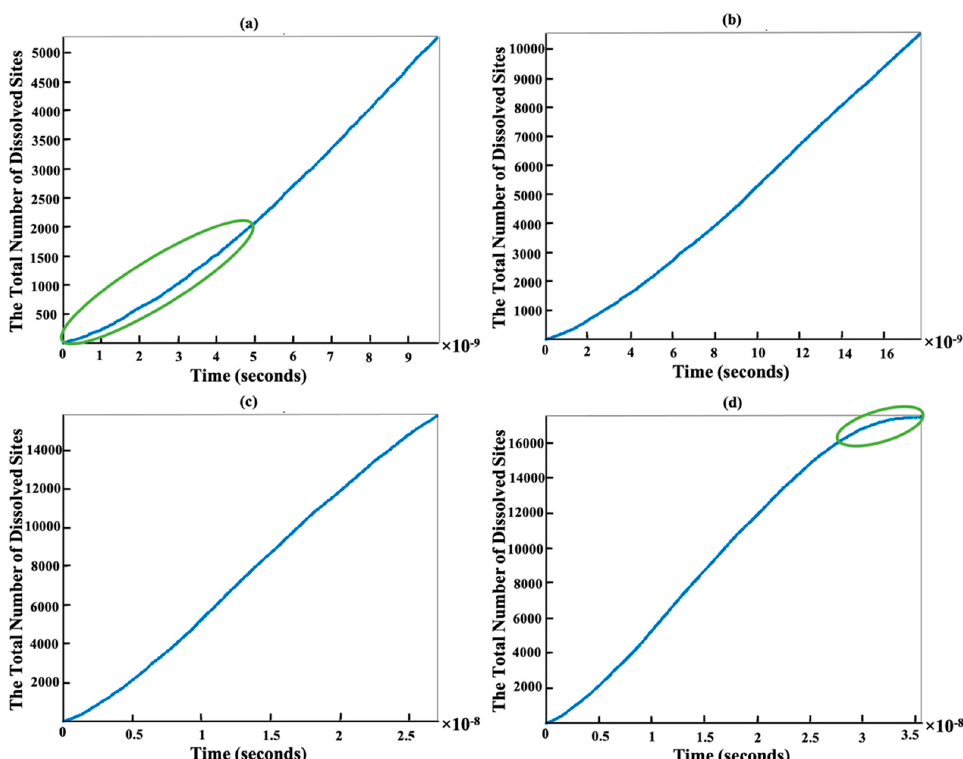
Figure 8. Time evolution of sites dissolution for the crystal morphology consisting of 17,461 sites during 5250 ( a ), 10,500 ( b ), 15,750 ( c ), and 17,461 ( d ) dissolution steps. Each step is representative of one site dissolution.